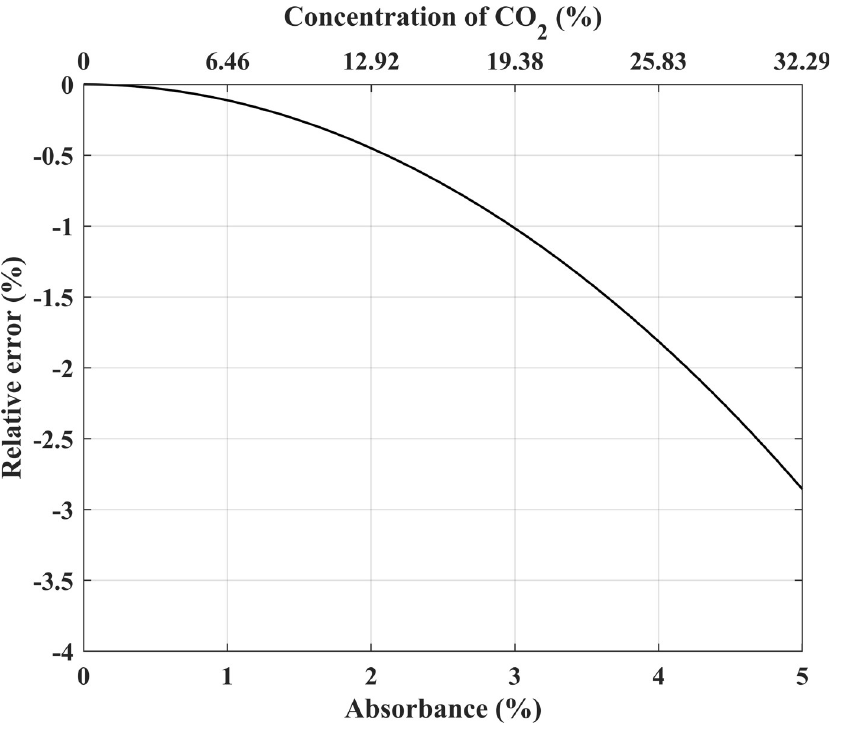
Fig 6. The relative error at the center of the second harmonic under different absorbances.